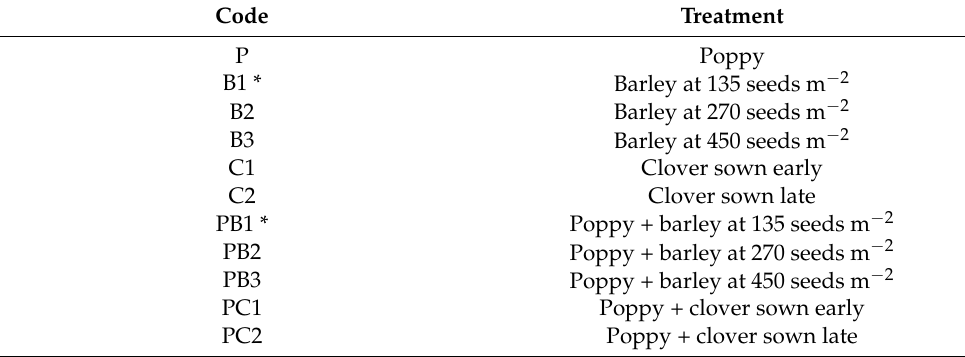
Table 3. Treatments of the poppy intercropping trial.